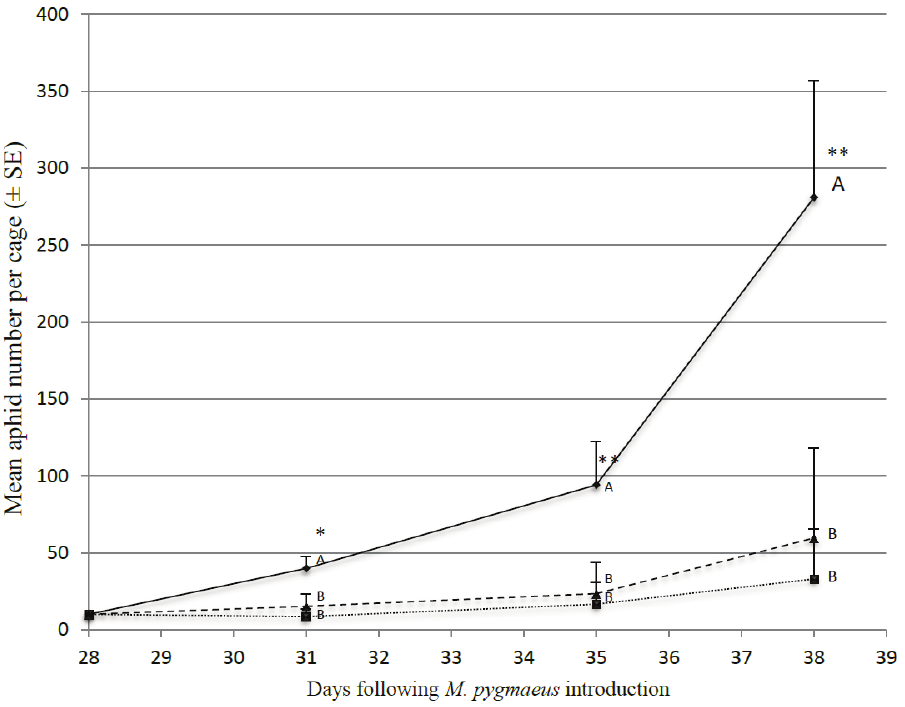
Figure 3. Evolution of mean aphid number per cage ( n = 4) in absence of predator (plain line), in presence of predator (dotted line and square dots) and in presence of predators and supplementary diet (dashed line with triangle dots).*, stars indicate mean aphid number statistically differing with the treatment; means sharing the same letter can not be considered as